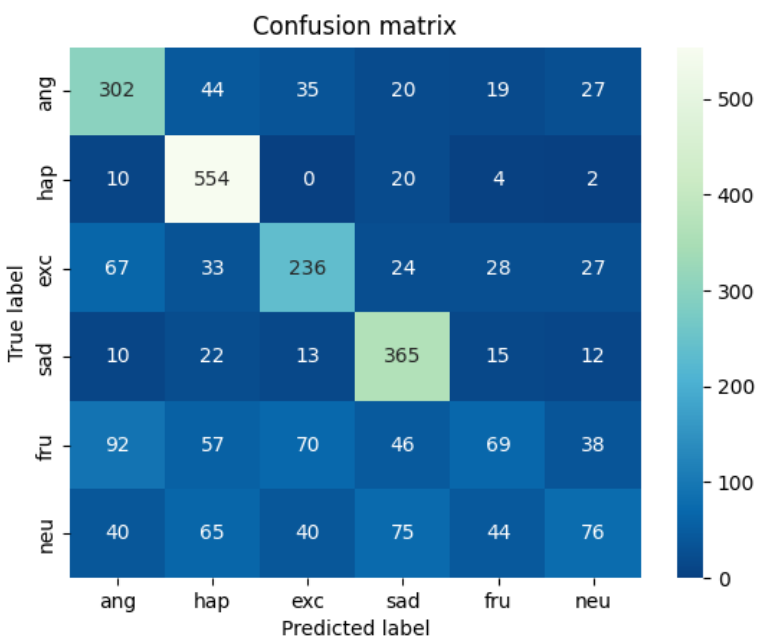
Figure 10. Speech Feature Heat Map of IEMOCAP Data Set (our model).